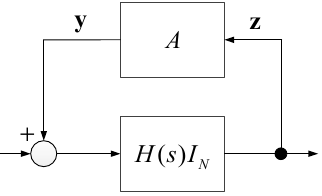
Figure 10. Representation of wheel velocity control system using DM-2 as a multi-agent-system.